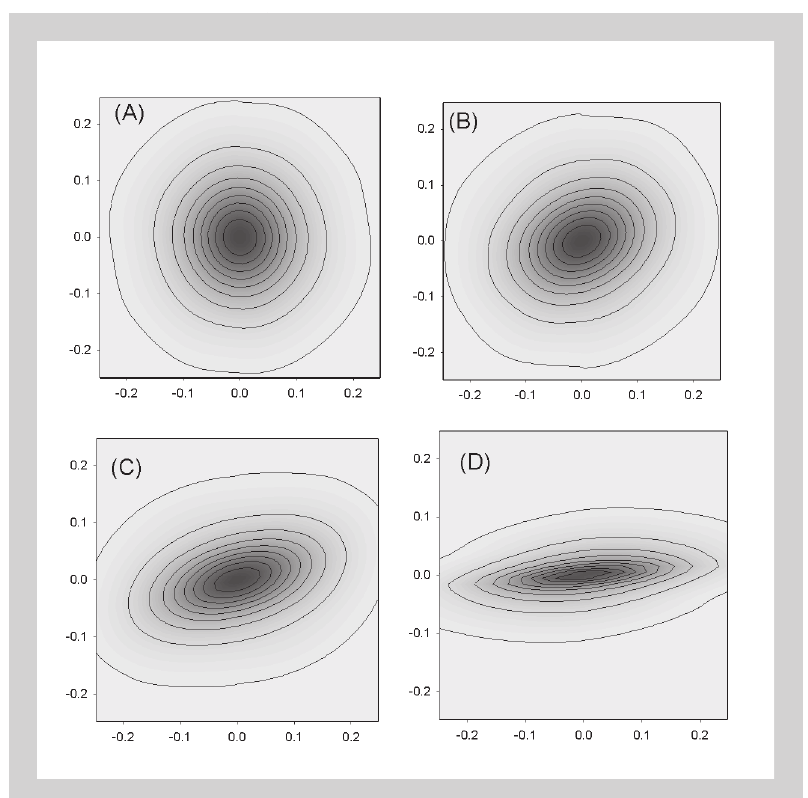
Figure 3: Scattering patterns produced by our polymer model and scattering geometry under shear rates of a) b = 0, b) bv = 1.19, c) b = 4.76, and d) b = 11.91. Screen coordinates normalized to the sample- screen distance d: horizontal axis, x/d, is the flow direction and vertical axis, y/d, the gradient direction. For a better appreciation, isolines corresponding to values of P( q , f ) between 0.1 and 0.9 are displayed as solid lines in intervals of